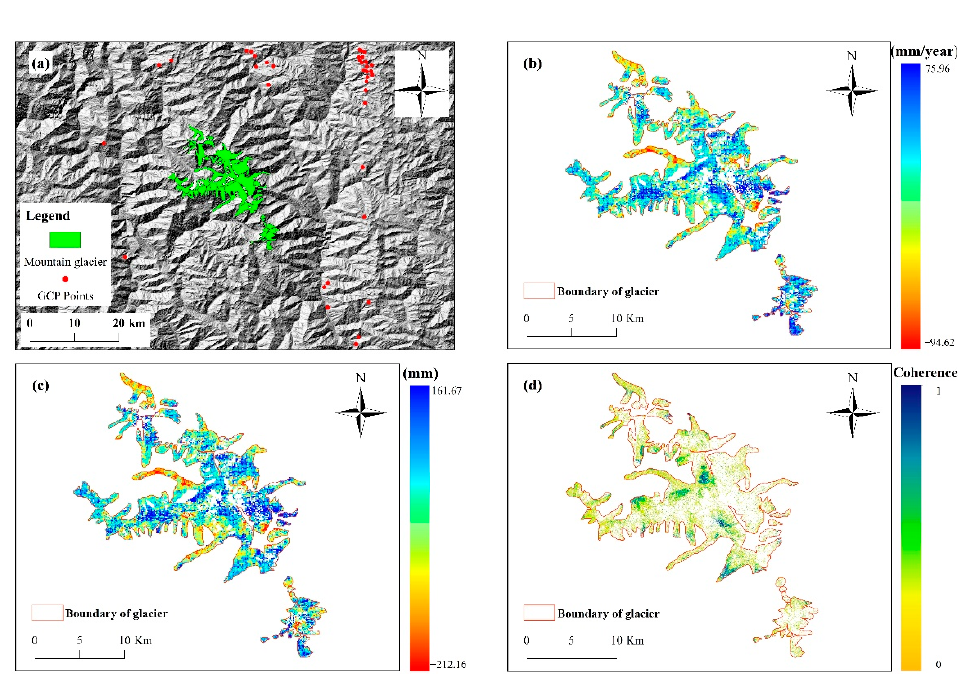
Figure 7. Time series deformation results for the Meili Mountain glacier, ( a ) GCP point, ( b ) deformation rates, ( c ) deformation variables, ( d ) average coherence of SAR images.